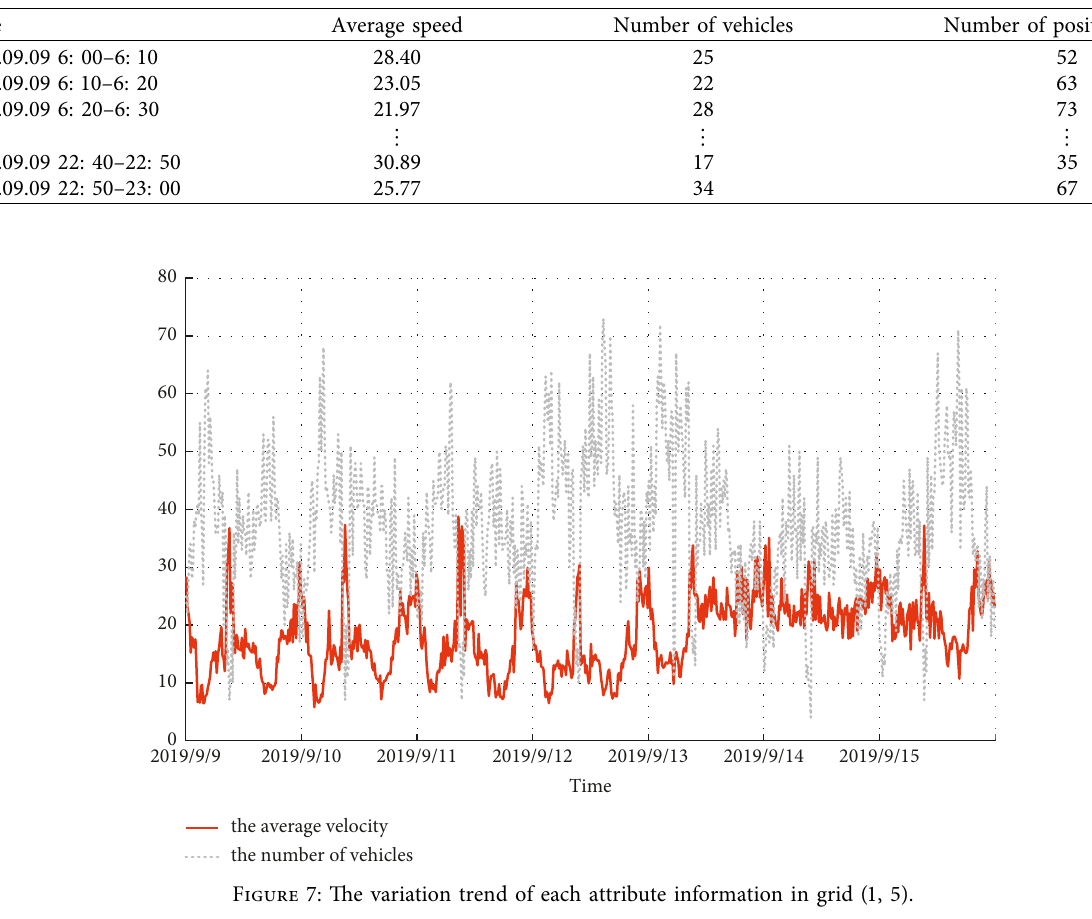
Figure 6: The trend of the average speed in grid (1, 5). (a) Trends in average speed with vehicle numbers. (b) Trends in average speed with GPS position point numbers. Table 3: Attribute information description of grid (1, 5).